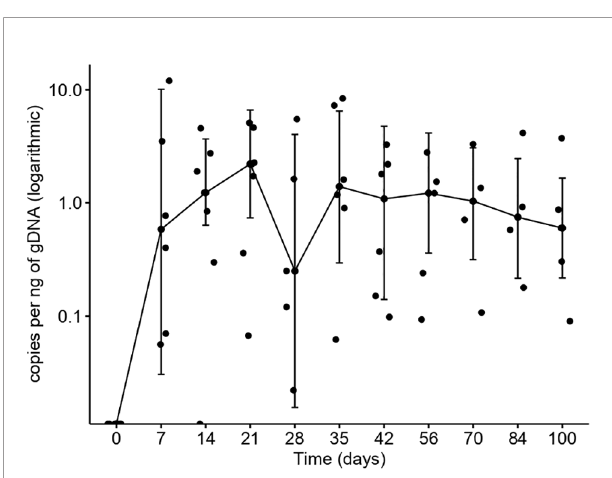
FIGURE 2 | ARI-0001 expansion over time, calculated by quantitative PCR, in patients with CLL/RT. Lines represent median